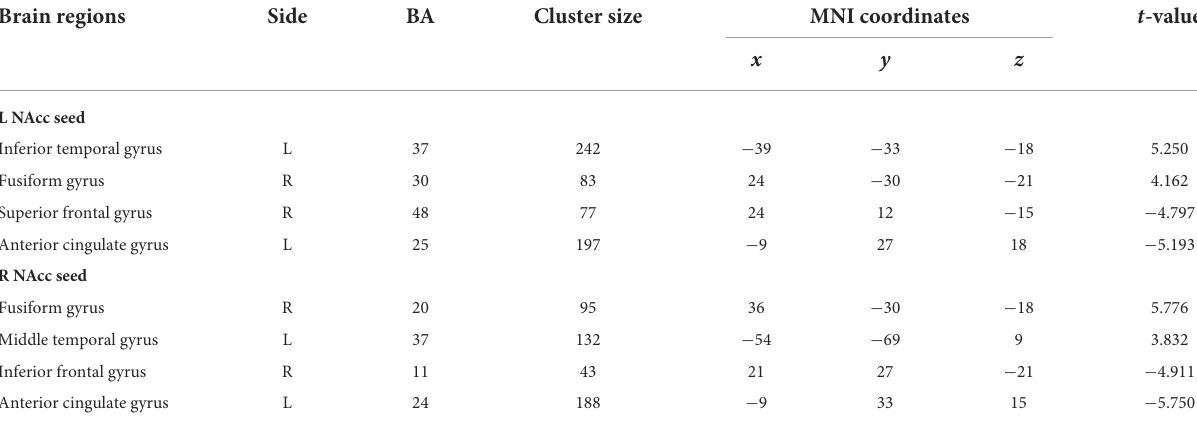
TABLE 3 Functional connectivity differences of the nucleus accumbens seeds between patients at baseline and controls (patients > controls). Brain regions